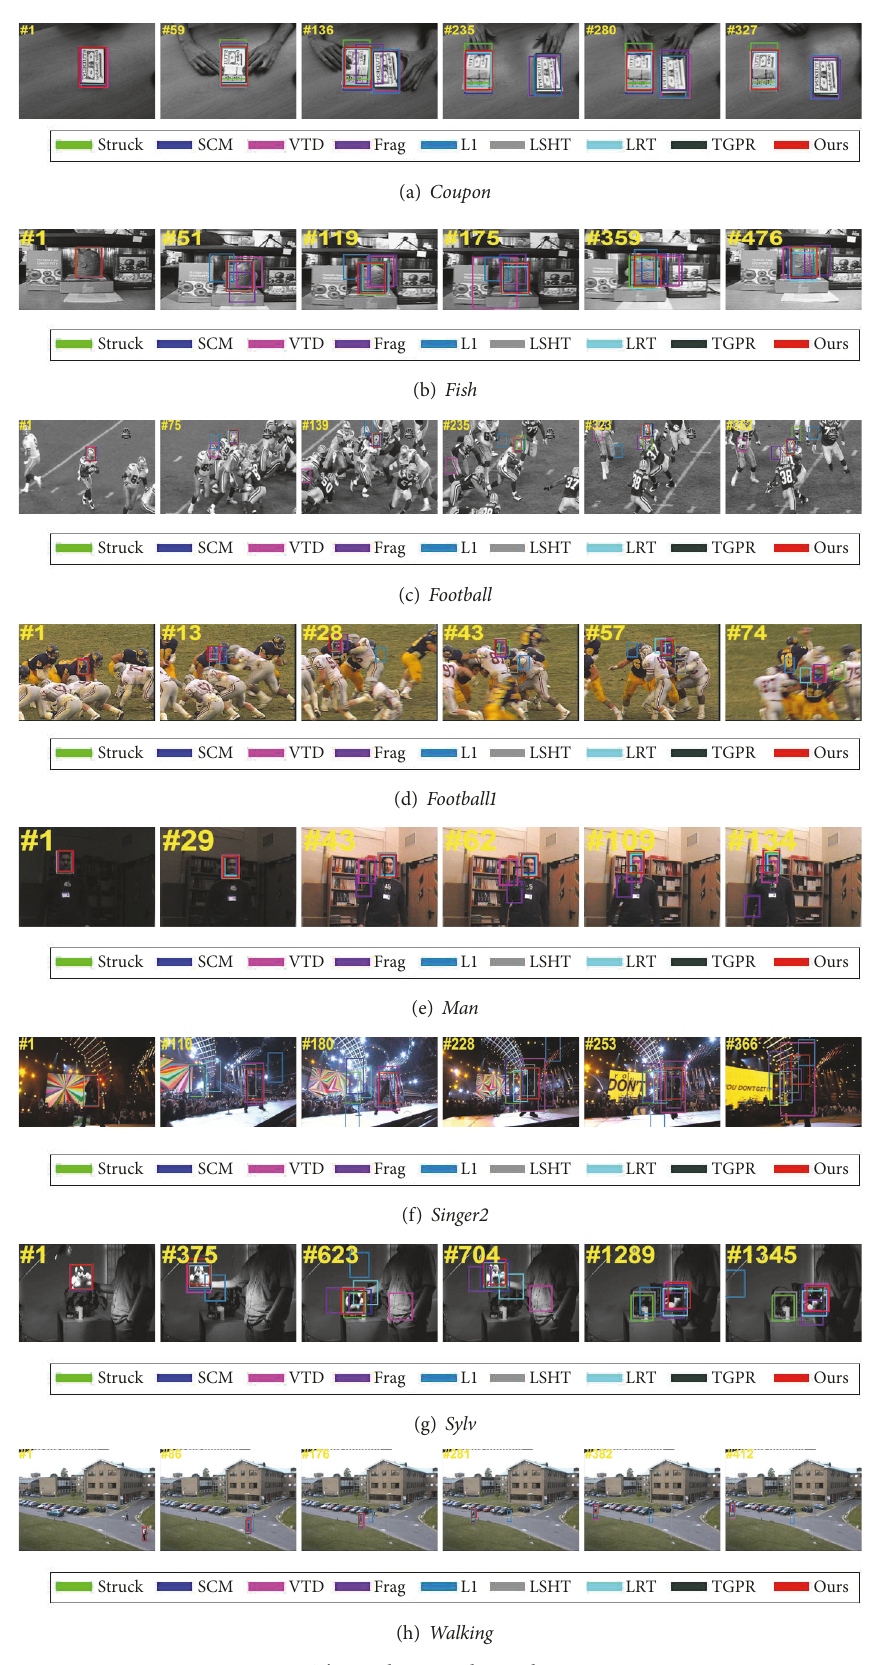
Figure 3: The tracking results on the 8